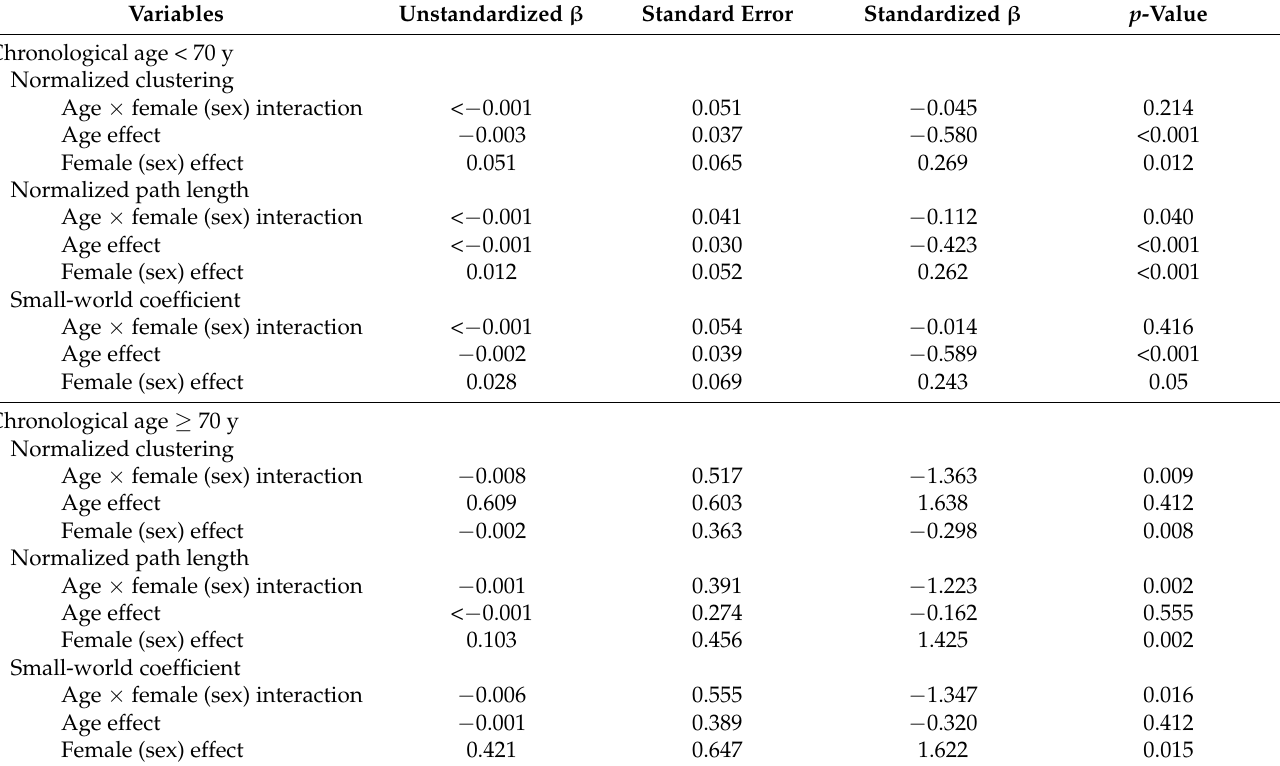
Table 2. Age- and sex-related network alterations in participants aged < 70 and ≥ 70